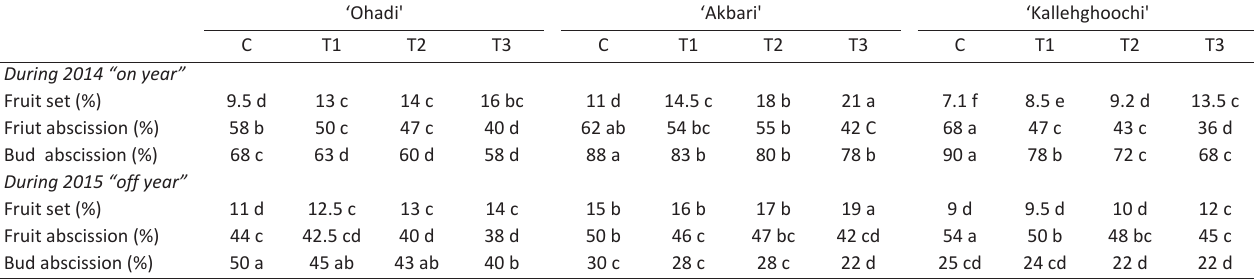
Table 2 - Interaction of stage of brassinosteroides application and cultivar for fruit and bud abscission and fruit set percentage of pista- chio in two years ‘Ohadi'